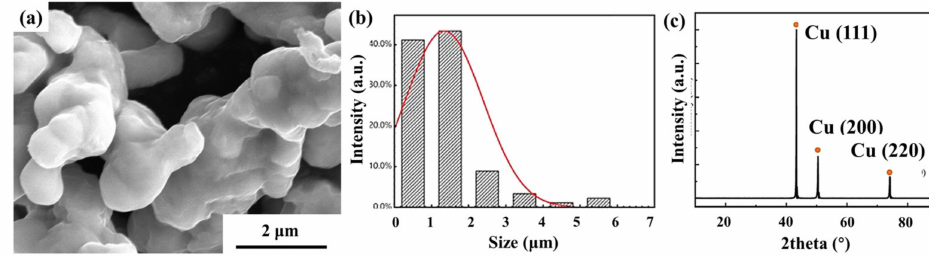
Figure 1. Original Cu powder morphology, particle size distribution and XRD characterization. ( a ) SEM of Cu powder, ( b ) particle size distribution, ( c ) XRD characterization of Cu